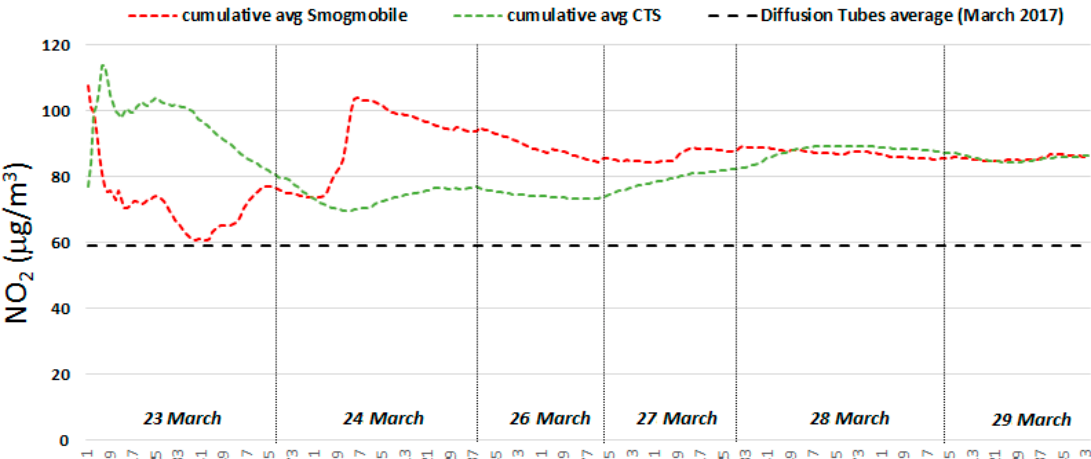
Figure 8. Cumulative average CMS (5-days), Smogmobile (5-days) and Diffusion Tube (Monthly) NO 2 concentrations, µg/m 3 (Survey Period, March 2017).